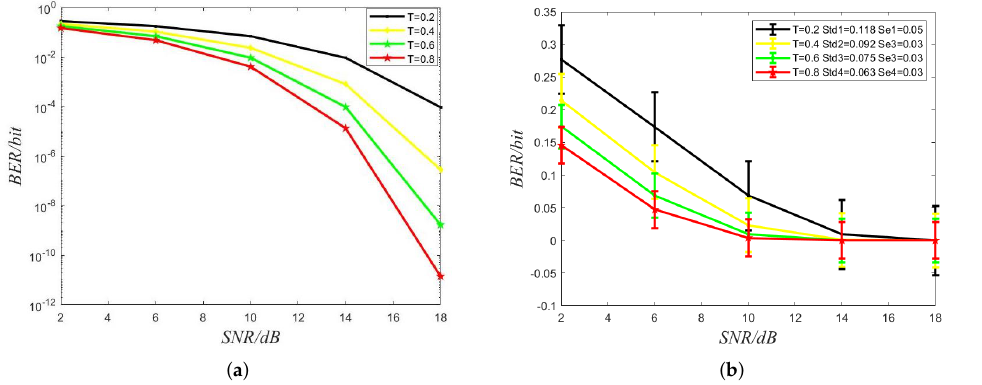
Figure 7. ( a ) Bit Error ratio (BER) versus signal-to-noise ratio (SNR) with the different symbol interval. dB denotes the unit of SNR. ( b ) Std and Se denote standard deviations and standard error, respectively.